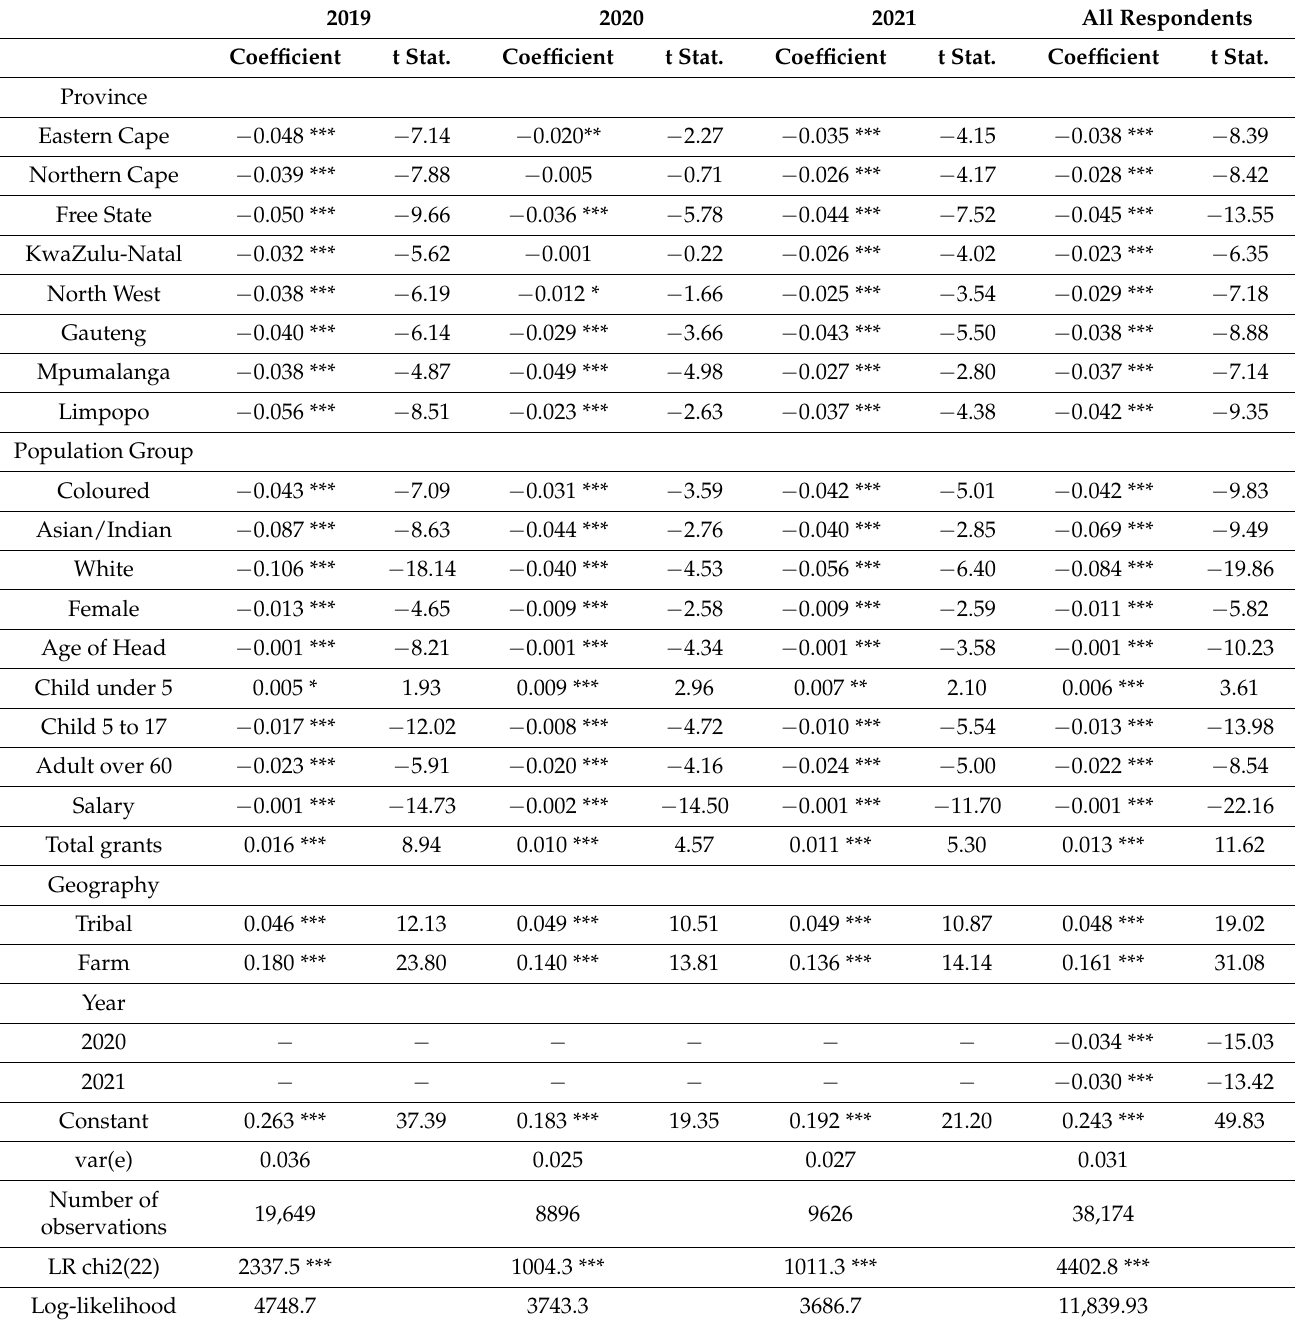
Table 3. Tobit results of the determinants of fuzzy MEPI